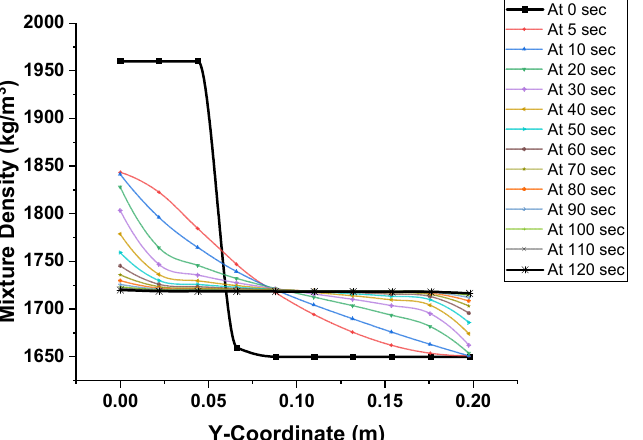
Figure 8. Mixture density curves at every 5 s interval from the start (at t = 0 s) to end time of the mixing process (t = 120 s).